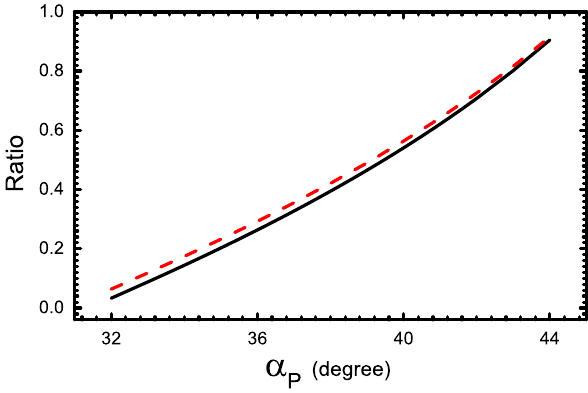
Fig. 4 (Color online). The α -dependence of the ratios R h mixing angle θ P = − 19 . 3 ◦ ( solid line ) and θ P = − 14 . 4 ◦ ( dashed line ), respectively